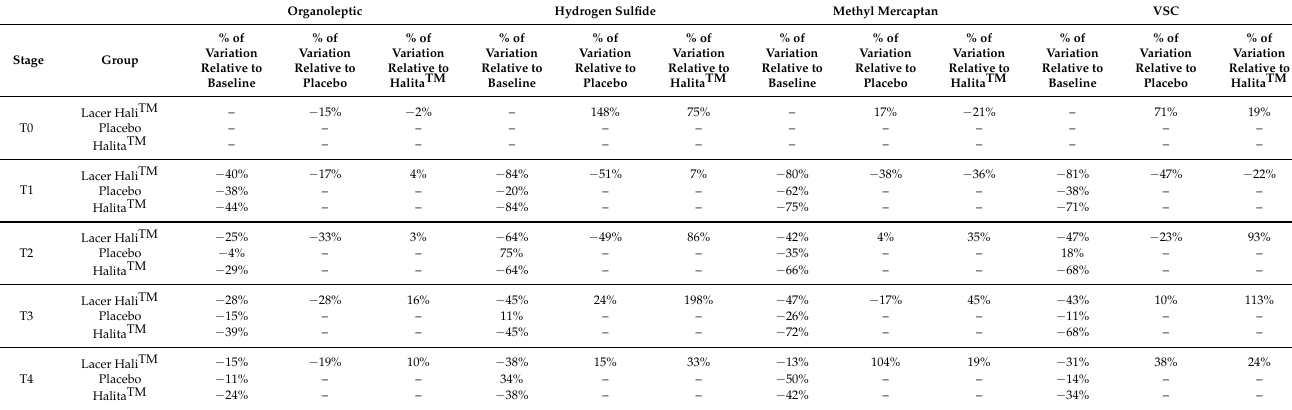
Table 2. Variations in odor intensity and the concentrations of hydrogen sulfide, methyl mercaptan, and total